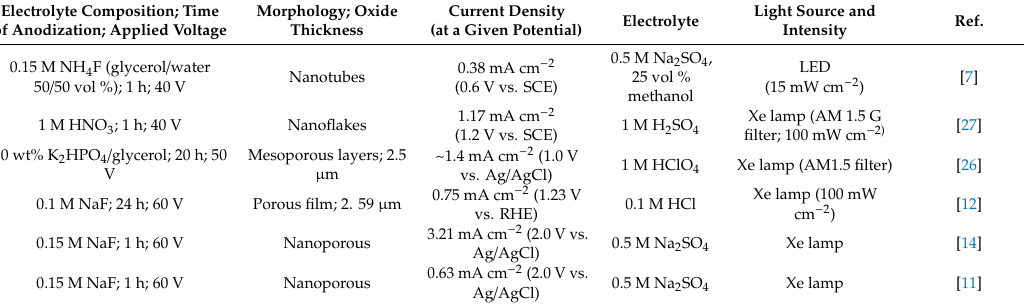
Light Source and Intensity